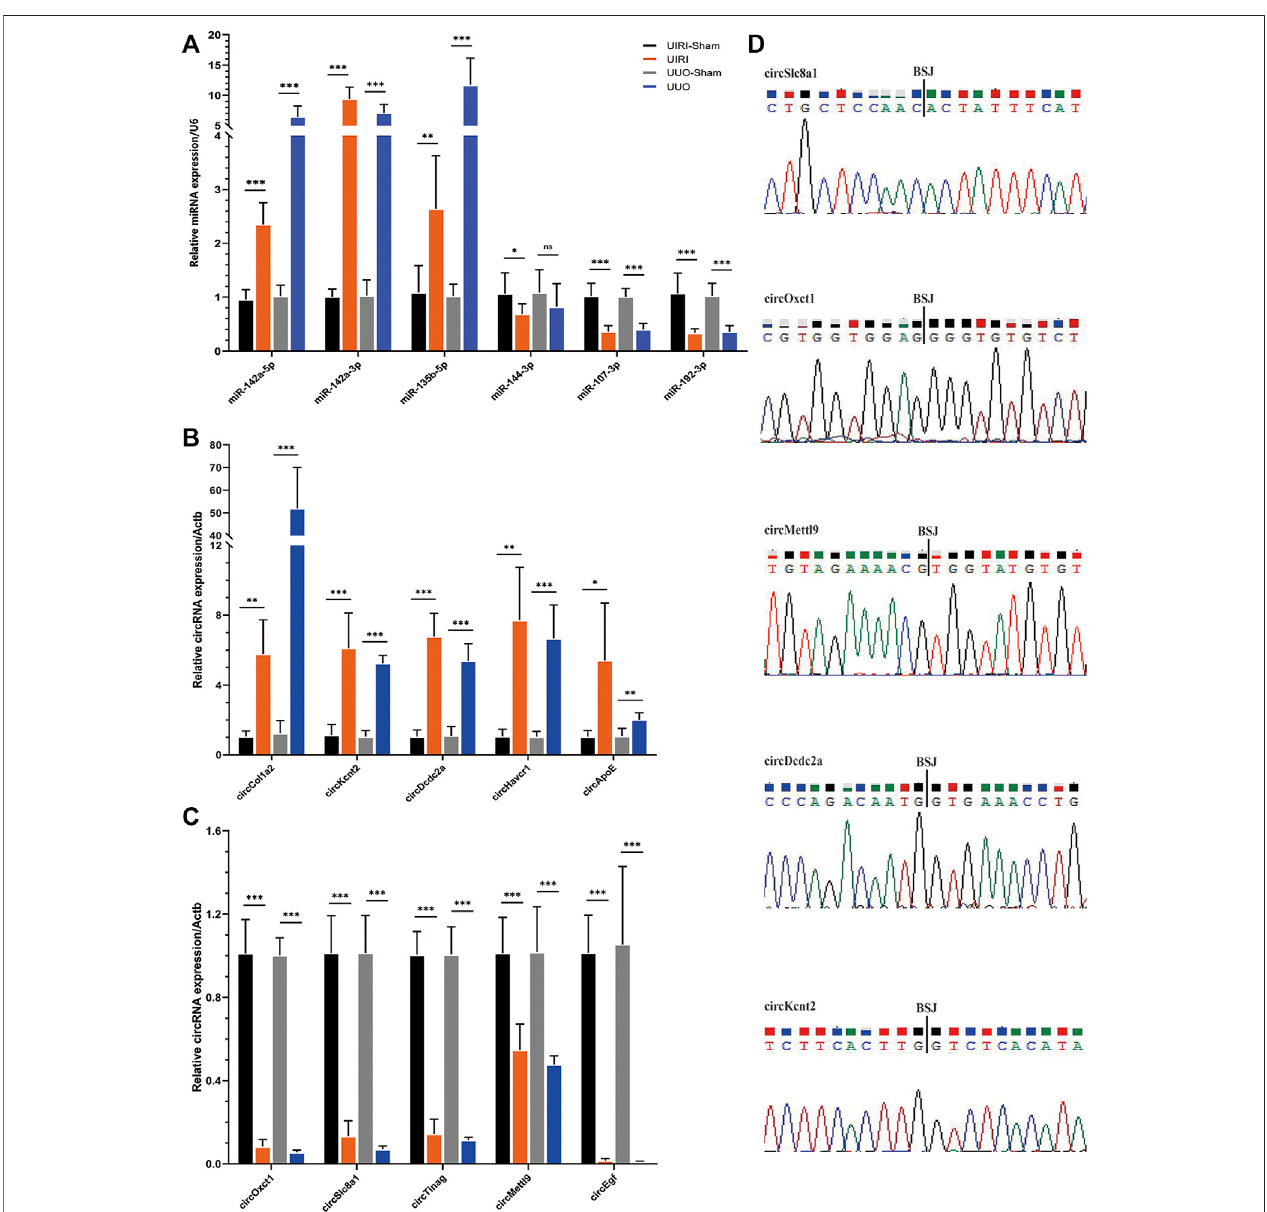
FIGURE 5 | Validation of the circRNA and miRNA expression. (A) The relative expression levels of the selected miRNAs detected by the RT – qPCR method. (B, C) The results of the fi ve upregulated and downregulated candidate circRNA expression levels by RT – qPCR analysis. * p < 0.05, ** p < 0.01, and *** p < 0.001 vs. sham group. (D) The back-splicing positions tested by Sanger sequencing. BSJ, back splicing